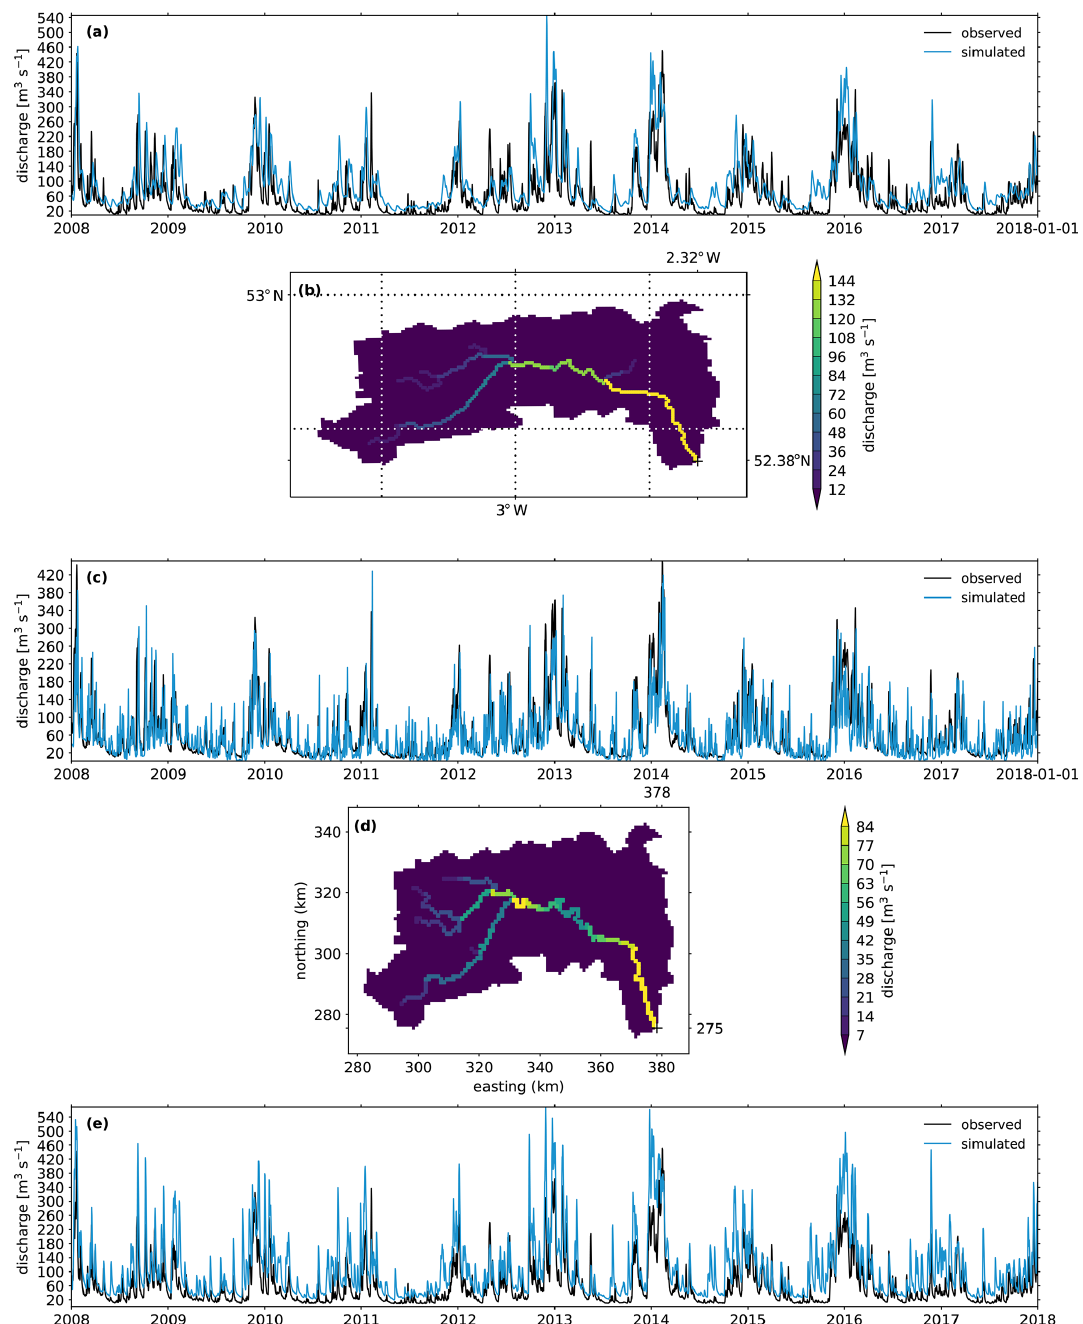
Figure B2. Simulation of the river discharge with the three configurations for the Severn catchment: (a) observed and simulated hydrographs with configuration 1 at the catchment outlet (2.32 ◦ W, 52.38 ◦ N), (b) gridded simulated discharge with configuration 1 for the last simulation step (1 January 2018), (c) observed and simulated hydrographs with configuration 2 at the catchment outlet (378, 275), (d) gridded simulated discharge with configuration 2 for the last simulation step (1 January 2018), (e) observed and simulated hydrographs with configuration 3 at the catchment